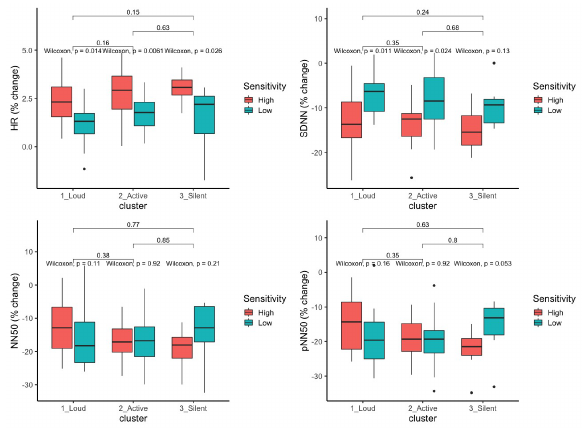
Figure 8: Relative change (%) in time domain HRV parameters for high and low noise sensitivity group.